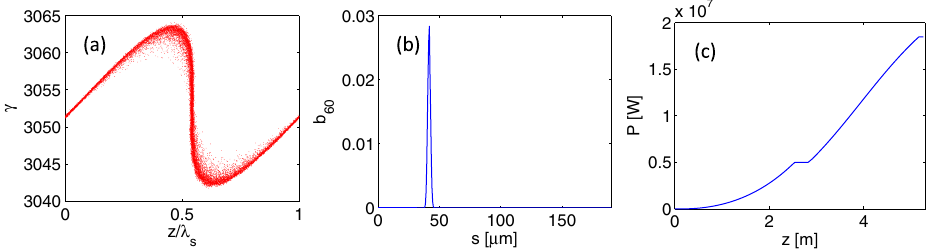
FIG. 7. Simulation results for the CHG: (a) Longitudinal phase space in one seed laser wavelength region at the entrance of R 1 ; (b) the 60th harmonic bunching factor distribution along the electron bunch at the entrance of R 1 ; (c) the gain curve of the FEL peak power in the R 1